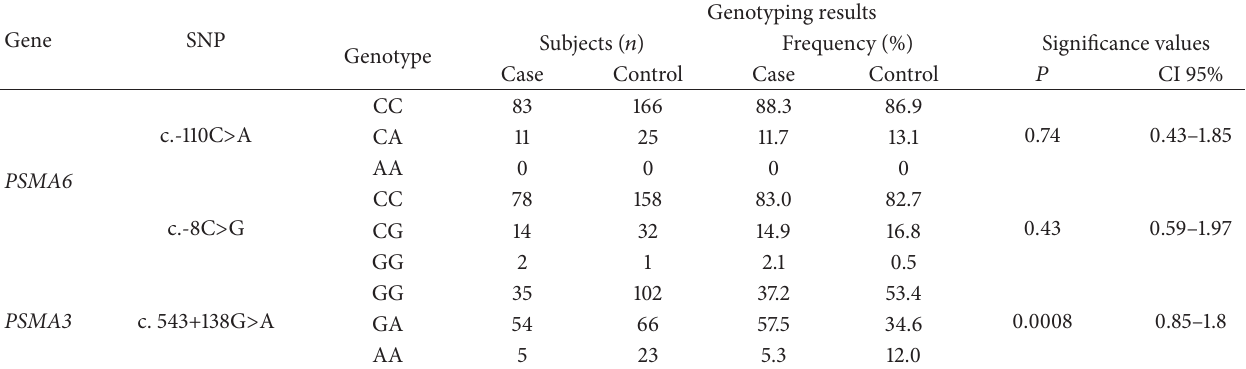
Table 3: Genotype frequencies in the obese case group ( 𝑛 = 94 ) and non-obese control group ( 𝑛 = 191